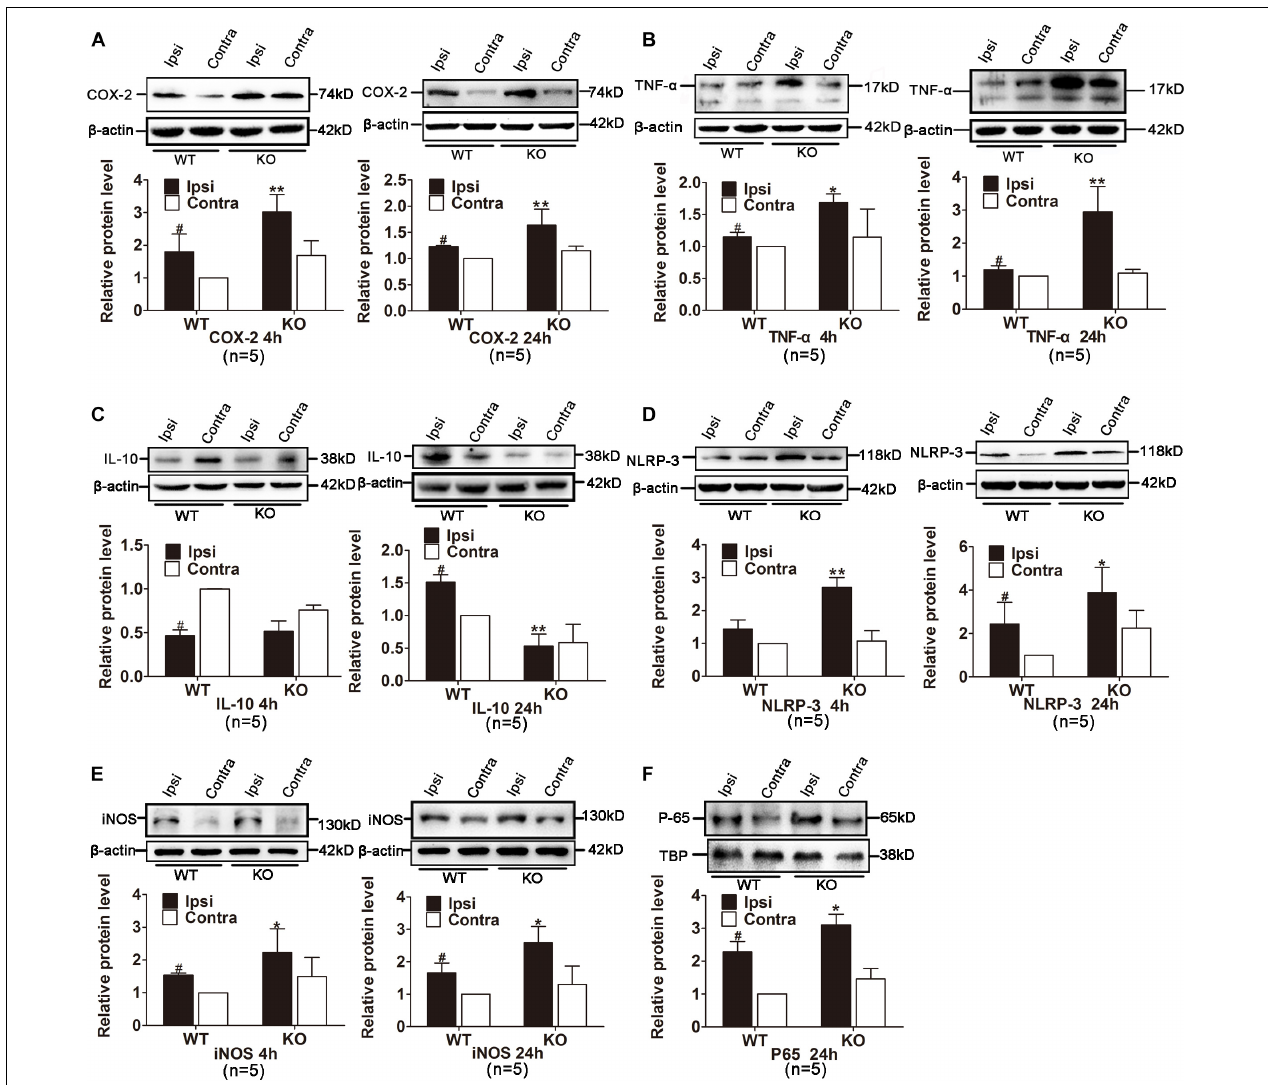
FIGURE 7 | Effects of IRAK-M deletion on protein level of ischemia-induced inflammatory cytokines in mouse brains. (A–E) Representative Western blot images of COX-2 (A) , TNF- α (B) , IL-10 (C) , NLRP-3 (D) and iNOS (E) at 4 h and 24 h after stroke in KO and WT mice. β -Actin was used as the loading control. (F) Representative Western blot images of NF- κ B P65 in nuclei in the ischemic hemisphere of KO and WT mice at 24 h after reperfusion. The relative protein level was quantified and normalized to β -actin using ImageJ. n = 5 per group. ∗ P < 0.05, ∗∗ P < 0.01 vs. WT group, # P < 0.05 vs. sham